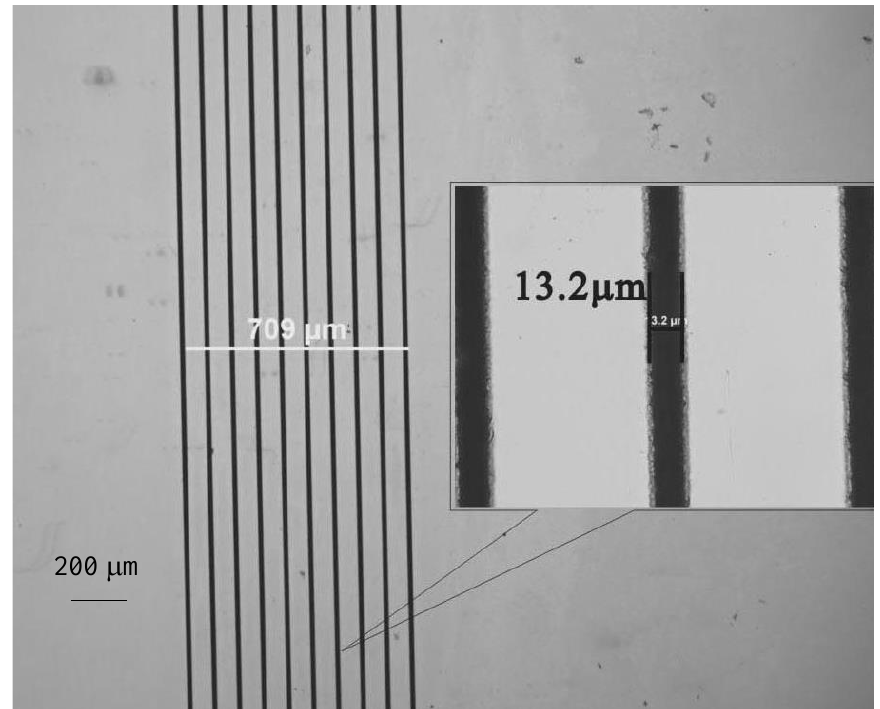
Figure 5. Optical micrograph of laser micro-machined features on a lithium niobate substrate. The distance across all the trenches is 709 µ m and the width of a single trench is 13.2 µ m. The 200 µ m scale bar is shown.